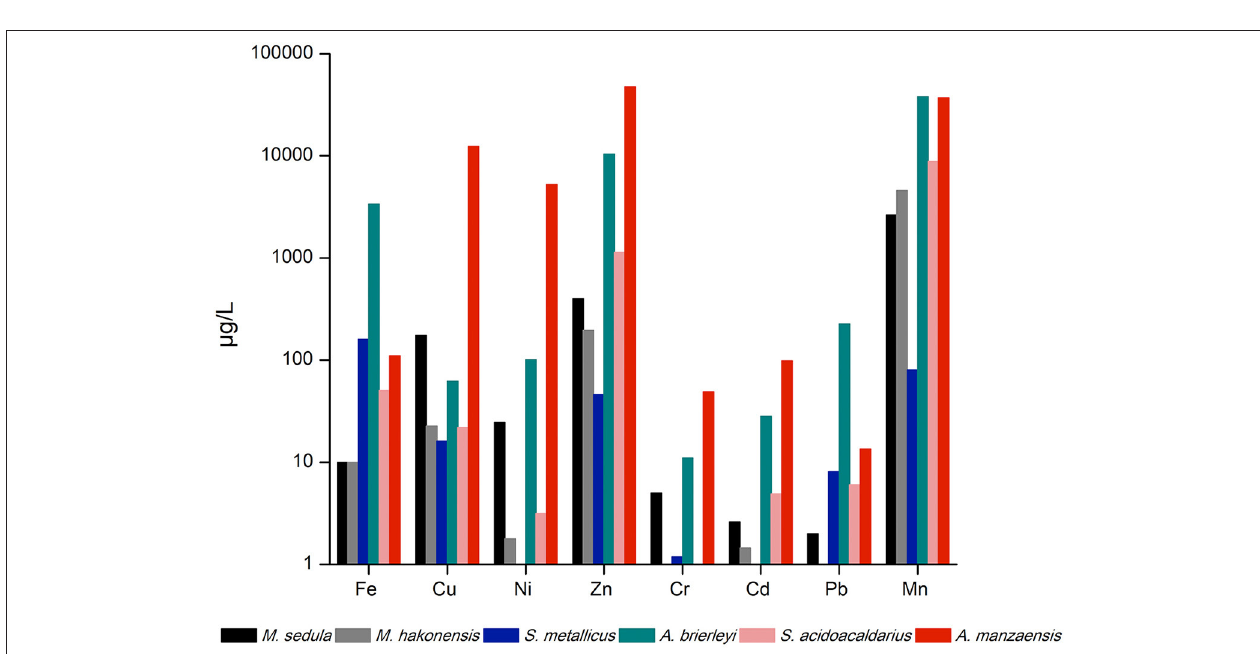
FIGURE 2 | ICP-MS analysis of released metal ions in the supernatant of thermoacidophilic cultures grown on BOF-dust (10 g/L).